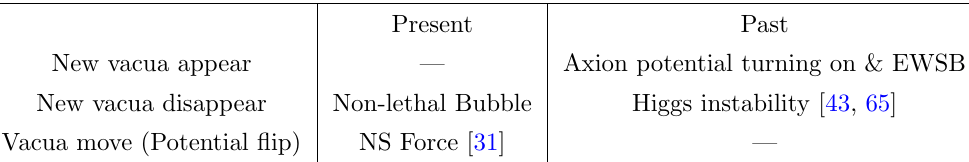
Table 1 . Scalar potentials can be a(cid:11)ected by thermal and density corrections. Minima can appear as the universe cools down both during the electroweak symmetry breaking (EWSB) and QCD phase transition. Vacua can disappear due to both density and thermal e(cid:11)ects and also move ((cid:13)ip sign) due to density